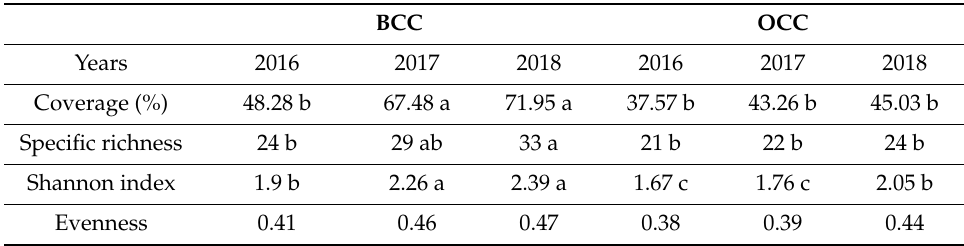
Table 4. Inter-annual variation of coverage, specific richness, and diversity index below the